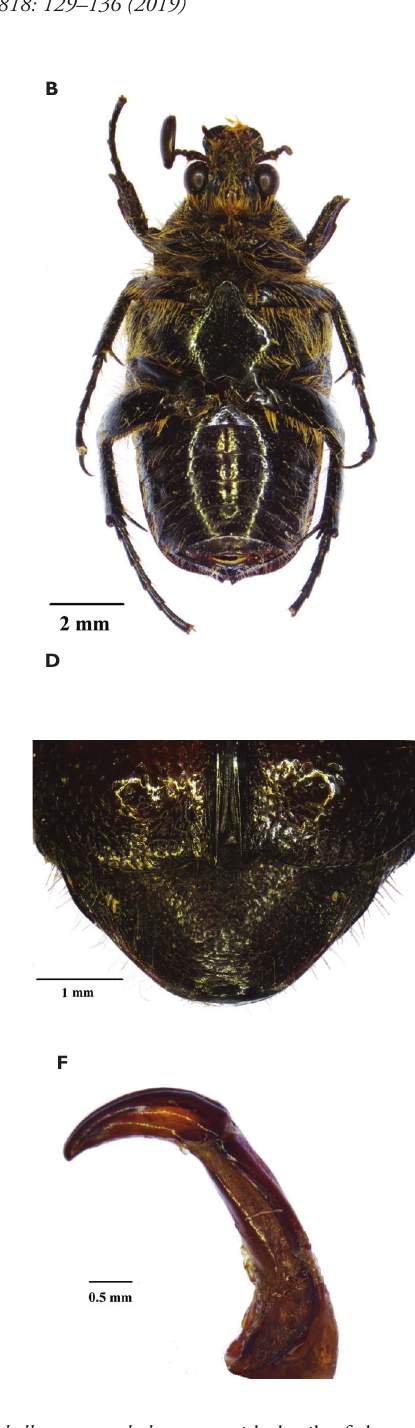
Figure 1. Dorsal ( A ) and ventral ( B ) habitus of Callophylla macrocephala sp. n., with details of clypeus ( C ), pygidium ( D ) and aedeagus in dorsal ( E ) and lateral ( F ) view (photographs Lynette